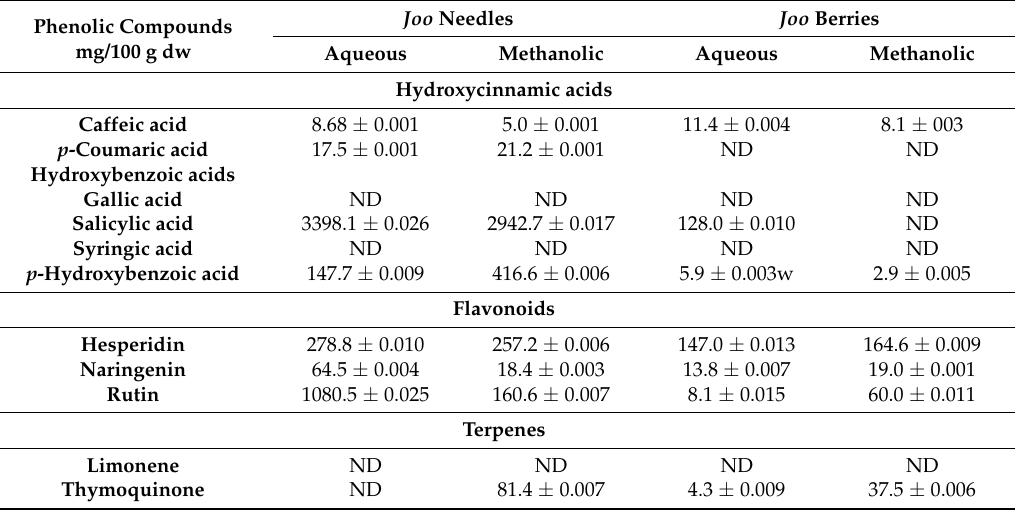
Table 1. Phenolic compositions and concentrations of examined Juniperus oxycedrus subsp. oxycedrus